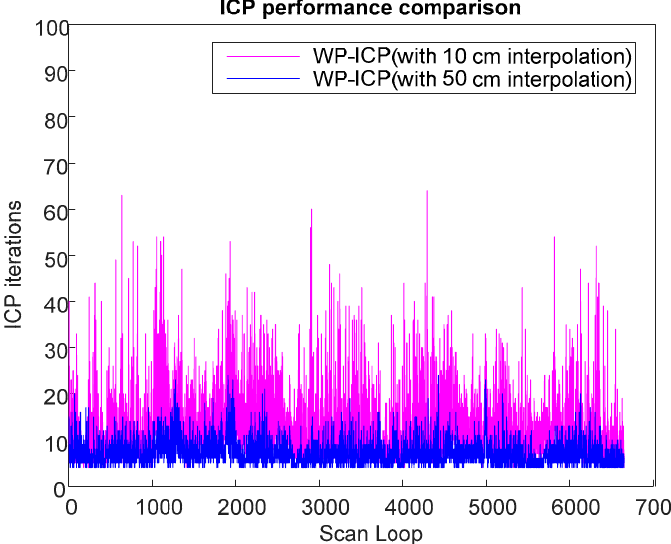
Figure 19. ICP performance of different interpolations.